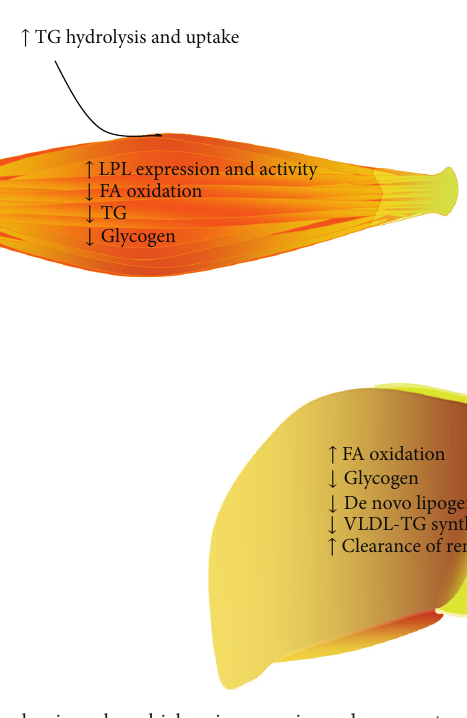
Figure 1: Potential mechanisms by which prior exercise reduces postprandial lipemia. Aerobic exercise has been shown to increase FA substrate utilization during metabolic studies presumably in skeletal muscle and liver. Increased hepatic FA oxidation and decreased de novo lipogenesis are thought to decrease VLDL-TG synthesis and secretion. Increased clearance of postprandial triglycerides through upregulation of LPL expression and activity has also been proposed in skeletal muscle and to a lesser extent in adipose